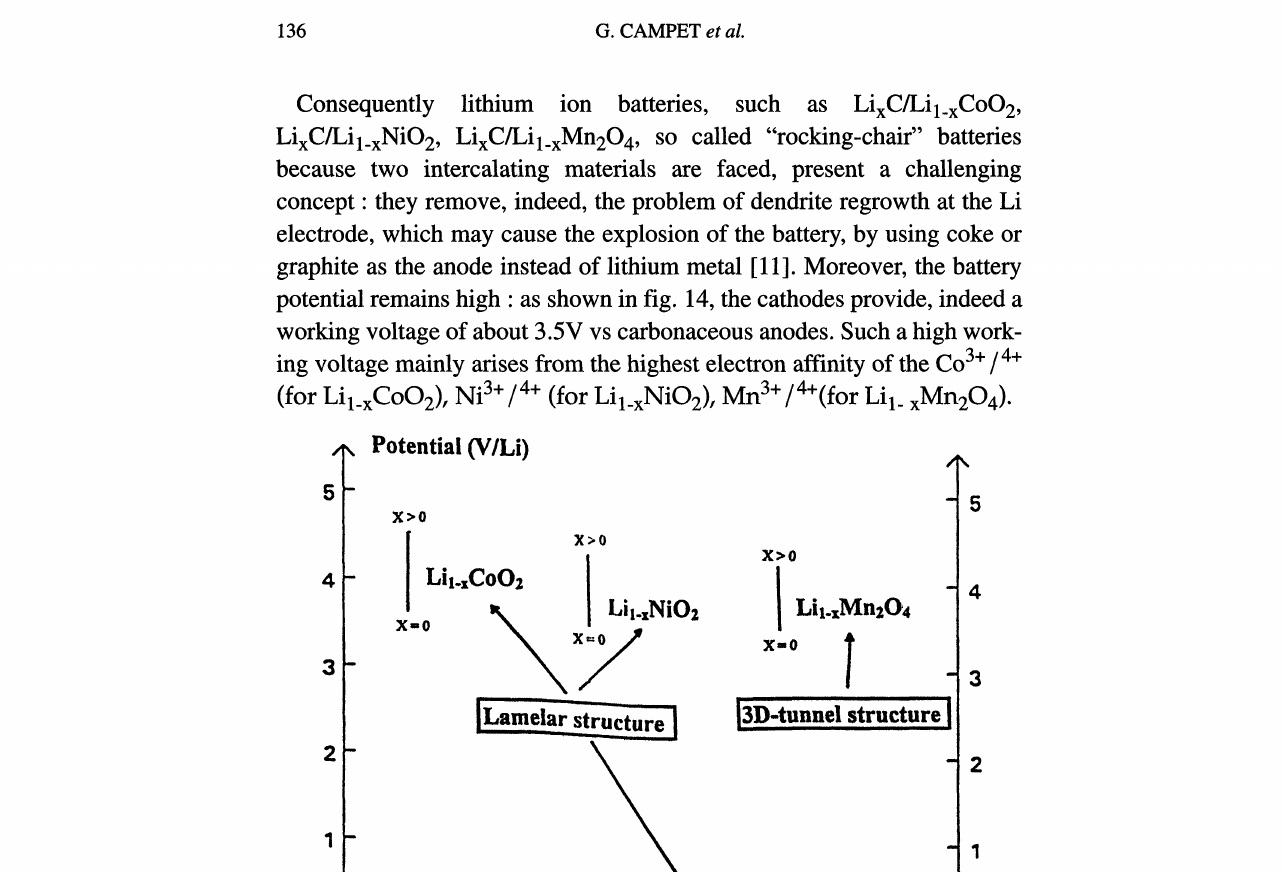
FIGURE 14 Comparison between the open circuit potentials ofthe electrode materials gen- erally used in "rocking-chair"